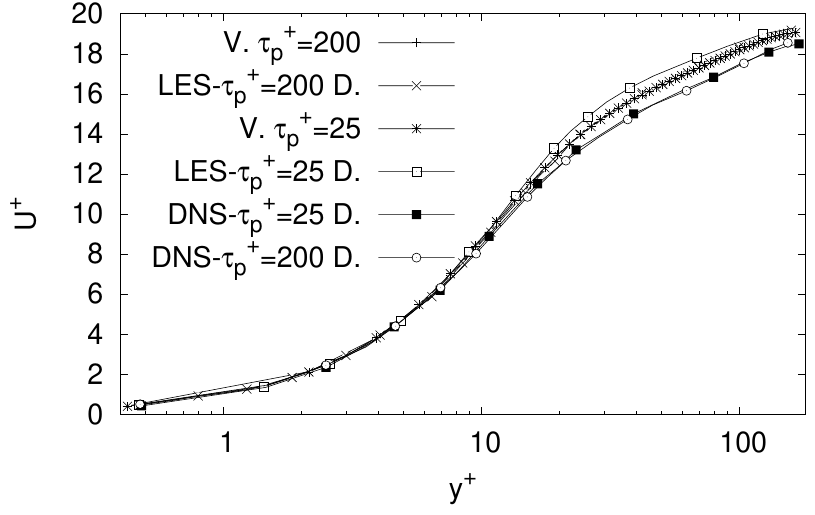
Figure 2. Mean velocity profiles obtained in the validation